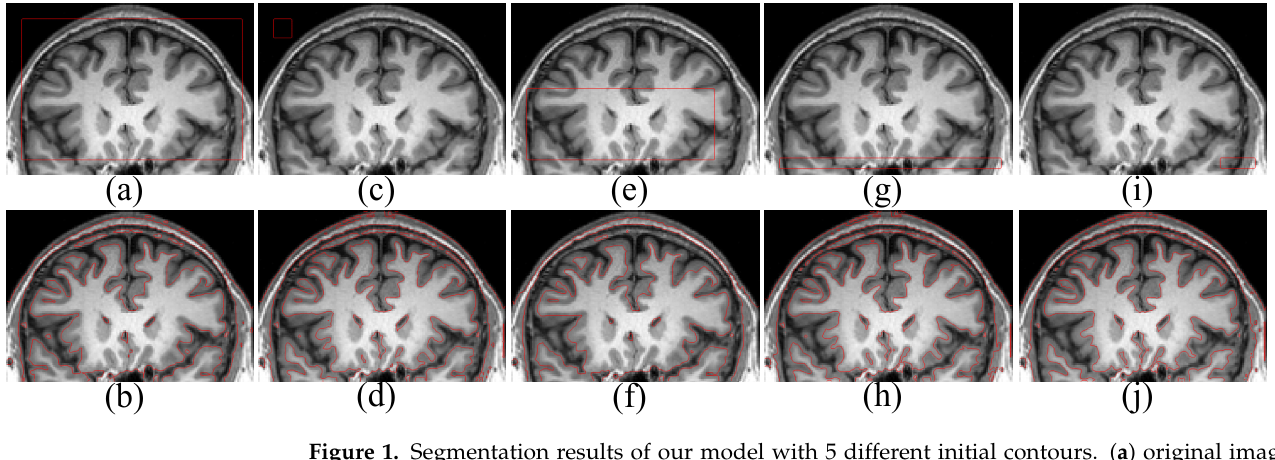
Figure 2. The corresponding evaluation index values of 20 different initial contours